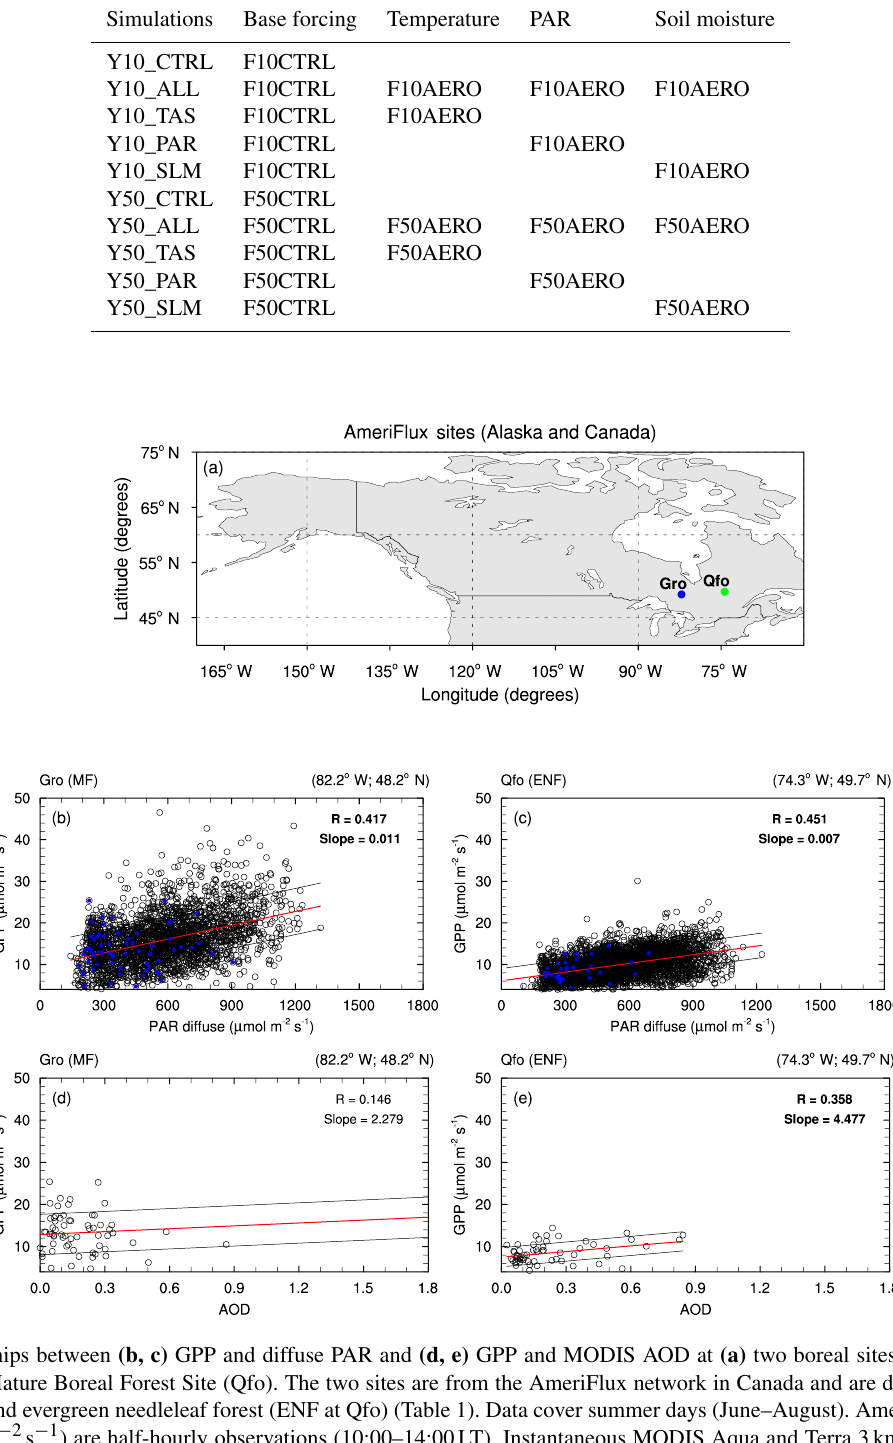
Table 3. Simulations with YIBs vegetation model driven by offline meteorology from ModelE2-YIBs climate model.